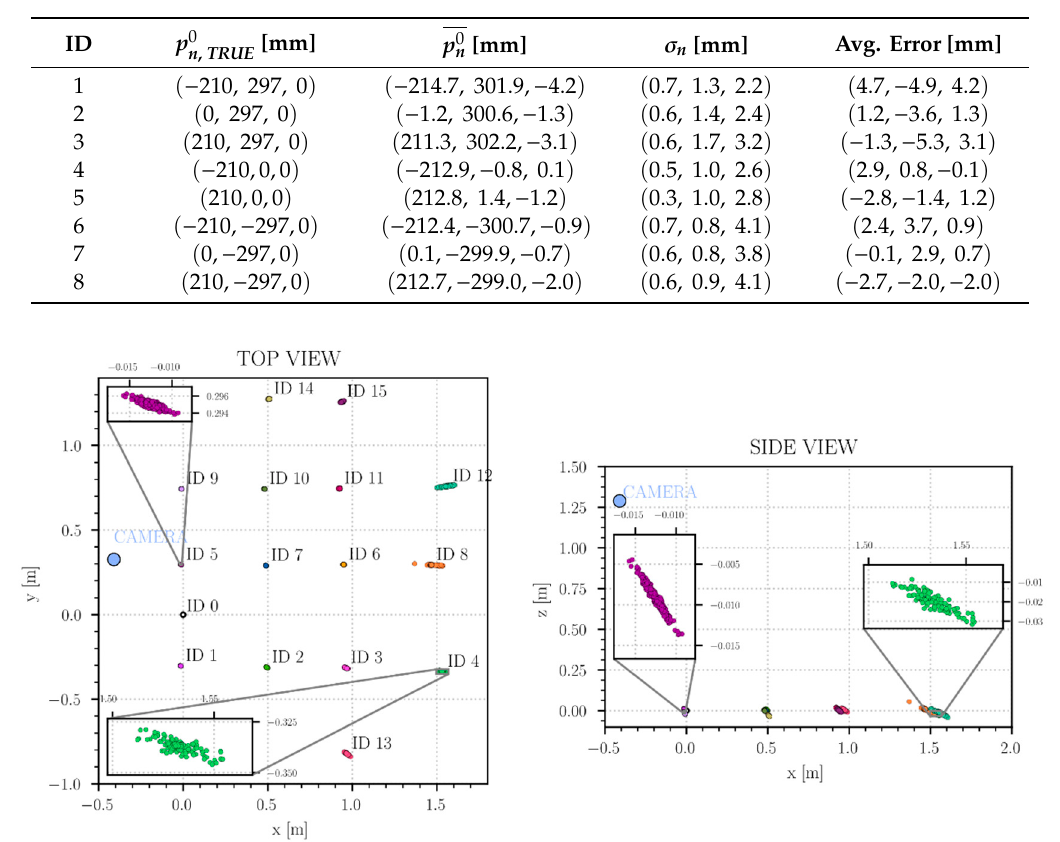
Table 2. Static test results: accuracy and uncertainty.